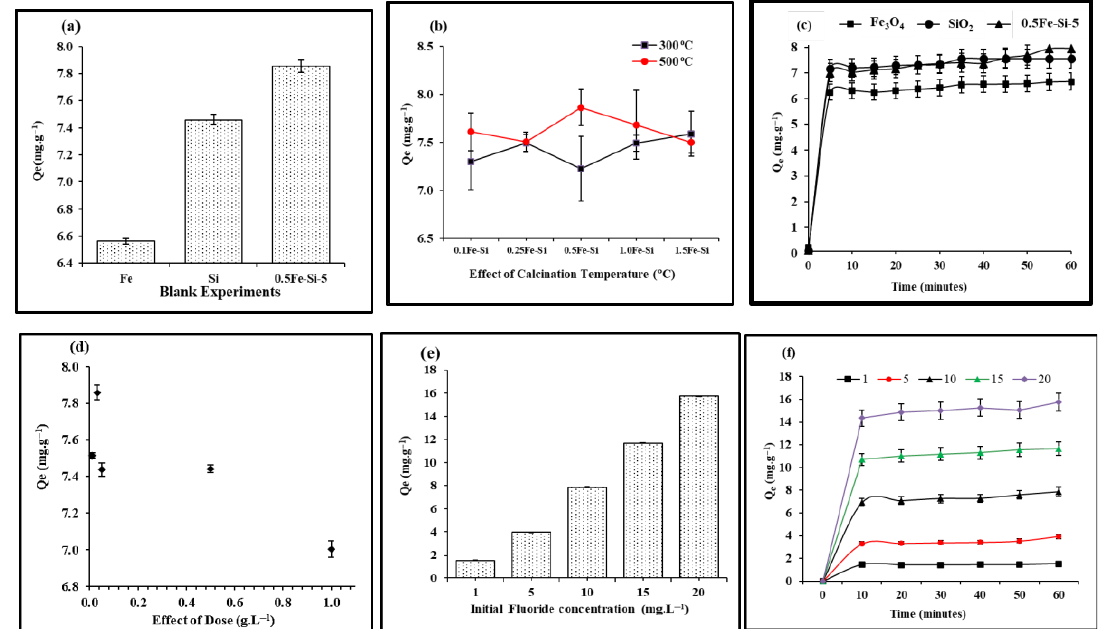
Figure 1. Screening and optimization studies of fluoride adsorption using synthesized NCs against various parameters. ( a ) Comparison of blanks using Fe 3 O 4 , SiO 2 , and 0.5-Fe-Si-5 NCs. ( b ) Effect of calcination temperature using Fe 3 O 4 -SiO 2 calcined at 300 ◦ C and 500 ◦ C. ( c ) Effect of contact time (min) using nanoparticles (Fe 3 O 4 and SiO 2 ) and their best performing 0.5-Fe-Si-5 NCs. ( d ) Effect of adsorbent dose (0–1.0 g L −1 ) using 0.5-Fe-Si-5 NCs. ( e ) Effect of initial fluoride concentrations (mg L −1 ) using 0.5-Fe-Si-5 NCs. ( f ) Fluoride quantity (Q e ) adsorbed at various initial fluoride concentrations (1–20 mg L −1 ) vs. time.